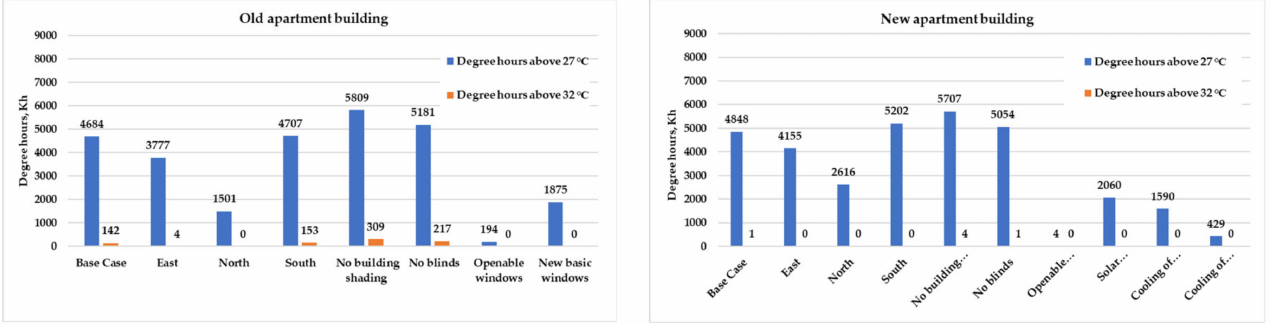
Figure 7. The annual degree hours above 27 ◦ C and 32 ◦ C in different cases of the old and new building with TRY2020 current climate.